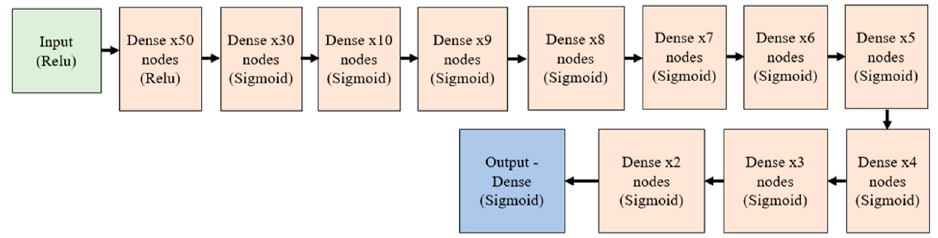
Figure 10. MLP model for numerical-based datasets.